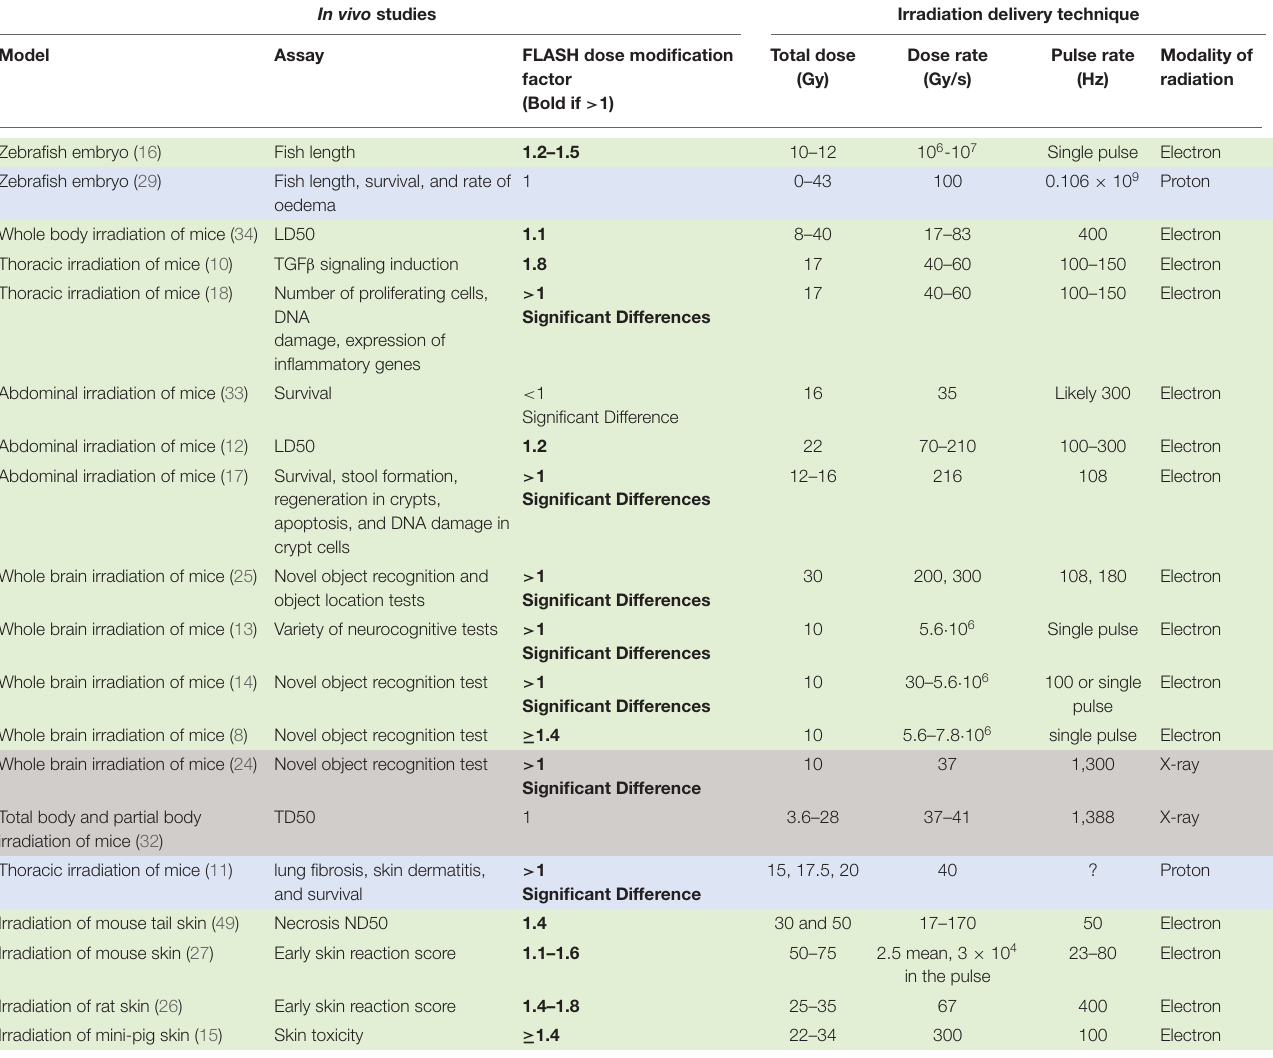
TABLE 1 | Summary of irradiation parameters and outcomes for in vivo studies investigating the FLASH effect in normal tissues (organized in order of model species and targeted tissue, as well as color coded by radiation modality). In vivo